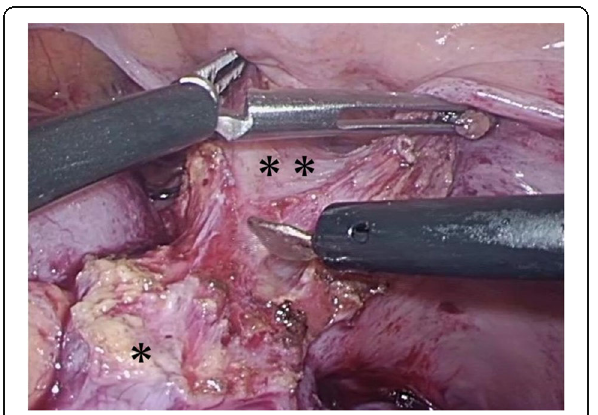
Fig. 2 Laparoscopic study of sigmoid colon during operation. The tumor did not spread to the serosa of the sigmoid colon (asterisk), but the colon strongly adhered to the abdominal wall (double asterisk) based on the intraoperative findings. A part of the abdominal wall was also